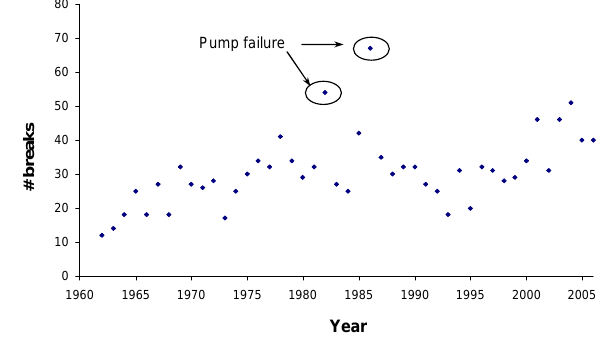
Figure 1. Breaks aggregated by Figure 1 . Breaks Aggregated by year